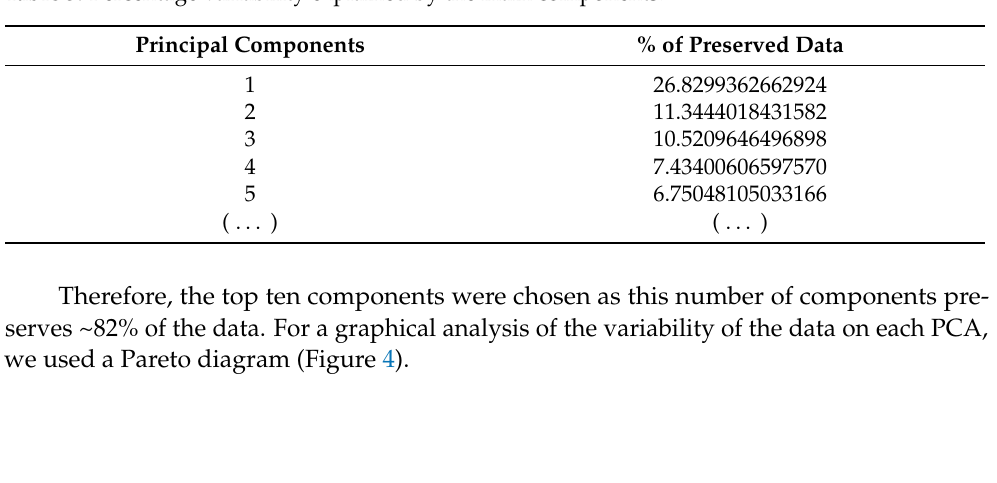
Table 3. Percentage variability explained by the main